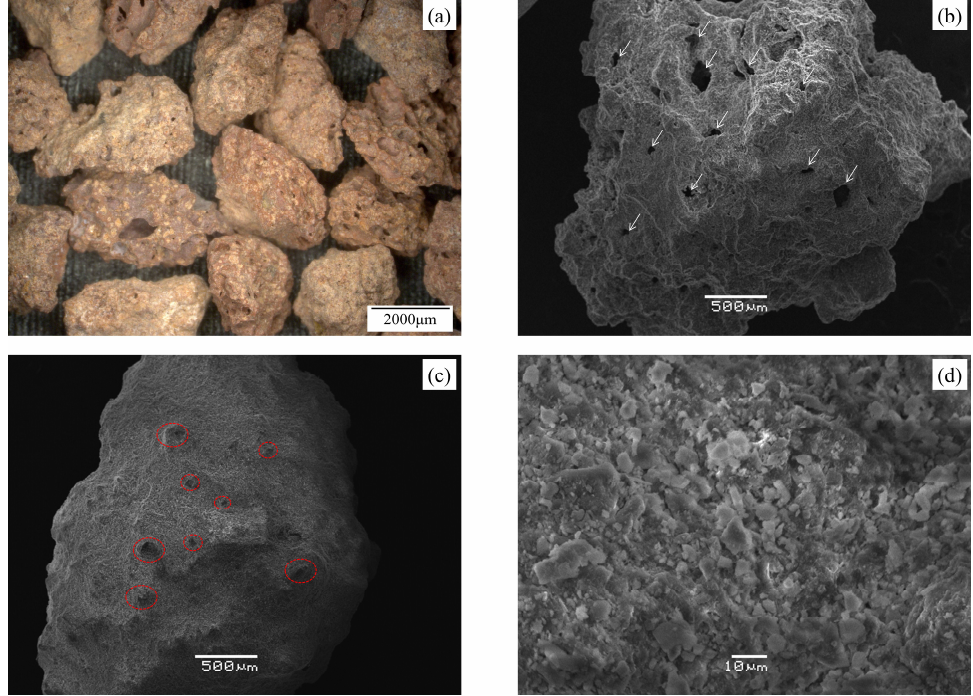
Figure 1. MMS-1 Mars regolith simulant: ( a ) Microscopic image of representative particles. SEM images of representative MMS-1 grains highlighting ( b ) pores, ( c ) protrusions and ( d ) natural surface coating.